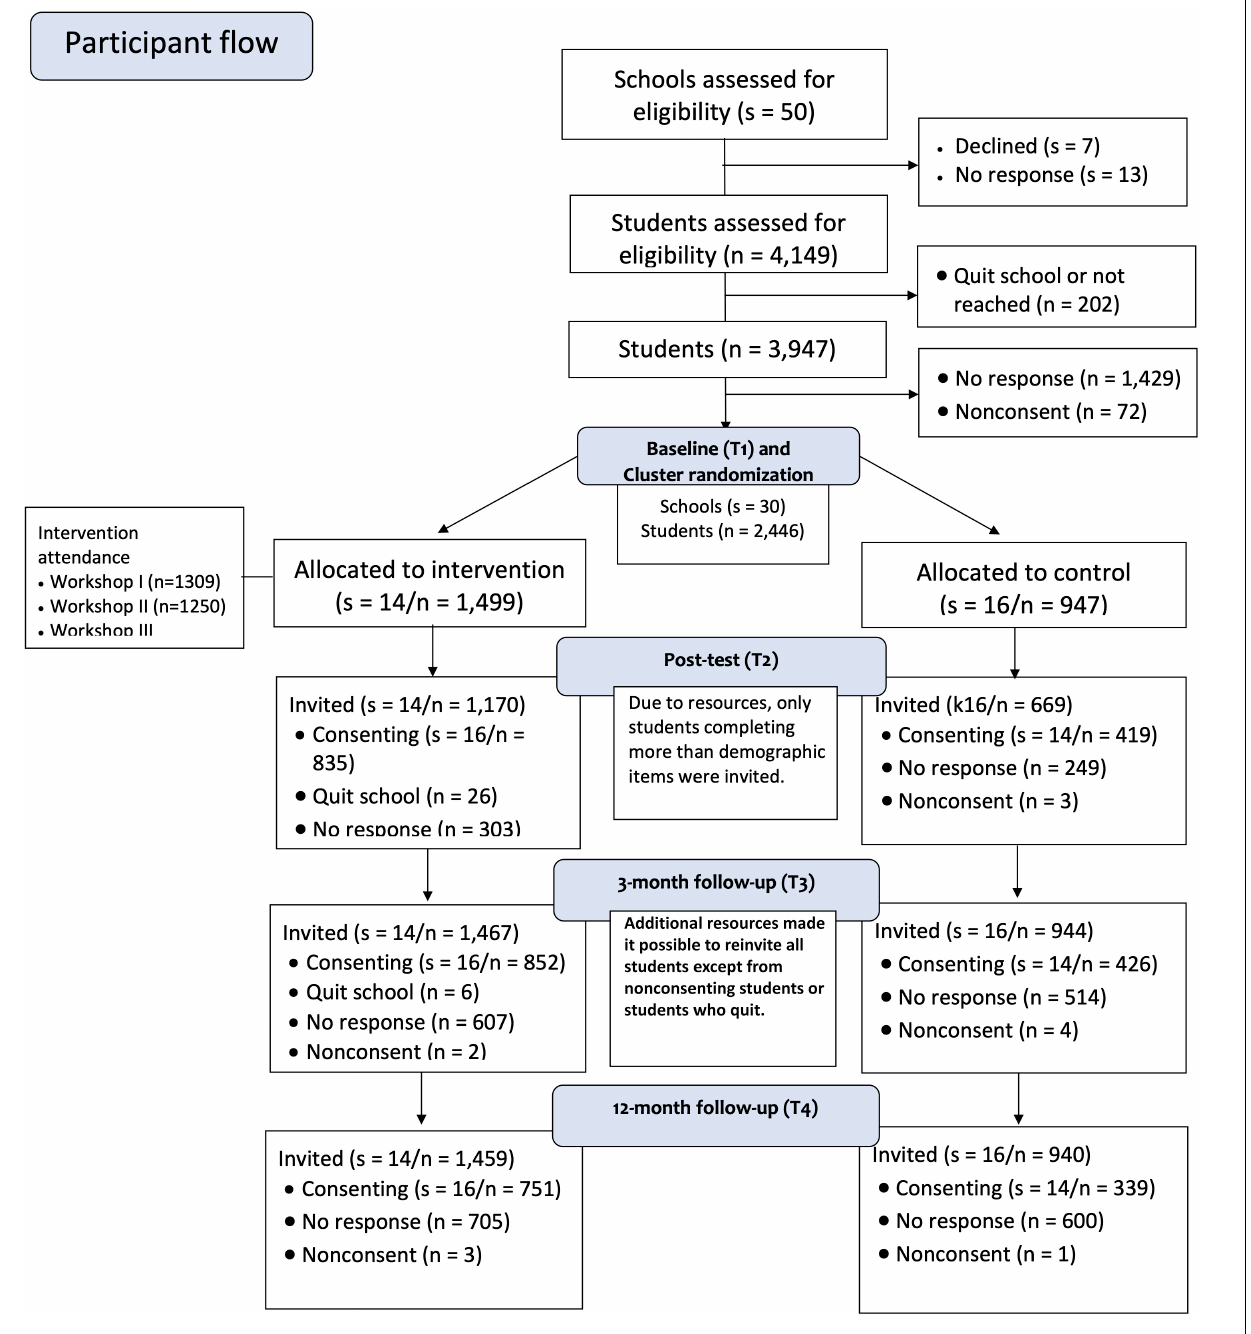
FIGURE 1 | Recruitment, randomization, and participant flow. s = number of schools (clusters), n = number of students. The figure presents the number of consenting students. The number of students for the outcome measures varies between the different